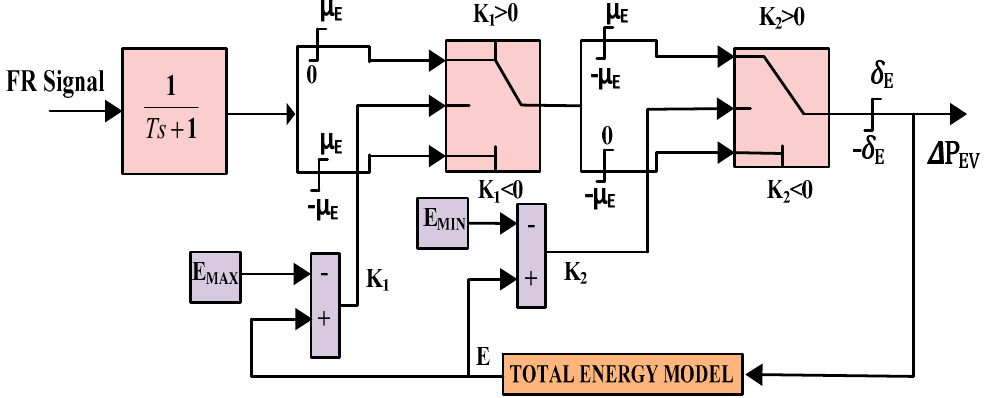
Figure 1. Frequency regulation model of EVs.